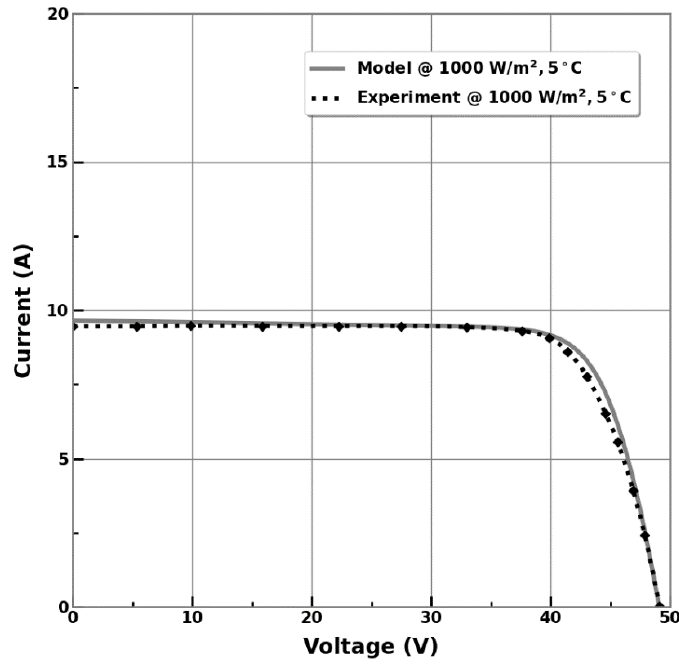
Figure 4. I – V chart — five parameters model vs. experiment. Figure 4. I–V chart—five parameters model vs.